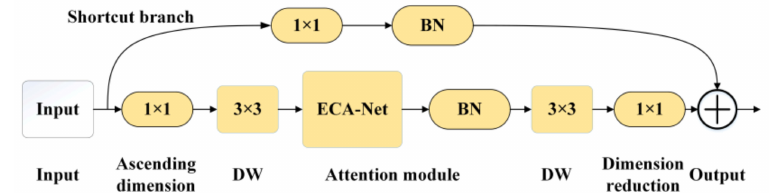
Figure 4. Double-layer separation residual